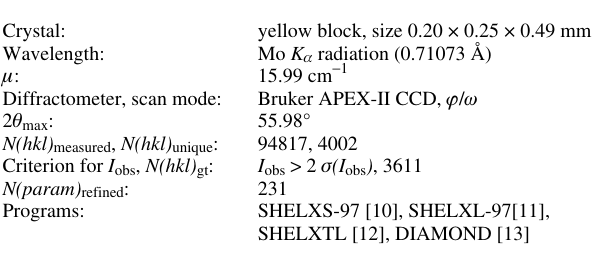
Table 1. Data collection and